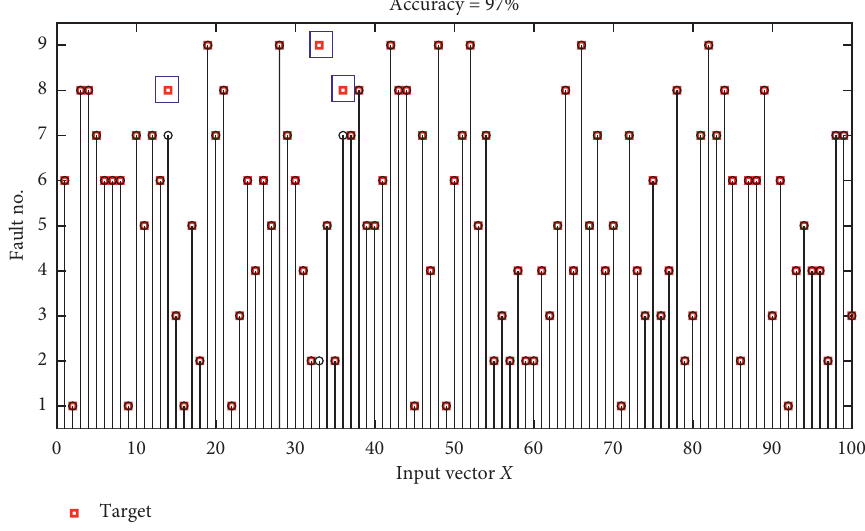
Figure 11: Classification results and